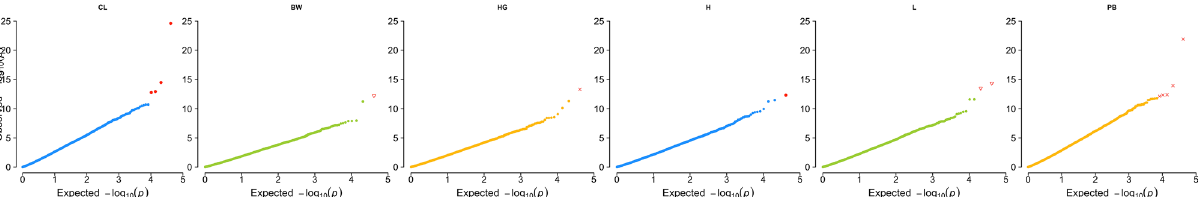
Figure 2. Genome wide QQ plot of the SNPs influencing CL = chest length, BW = body weight, HG = heart girth, H = height, L = body length, and PB = pubic bone length among Punjab goats using Caprine 50 K SNP Bead